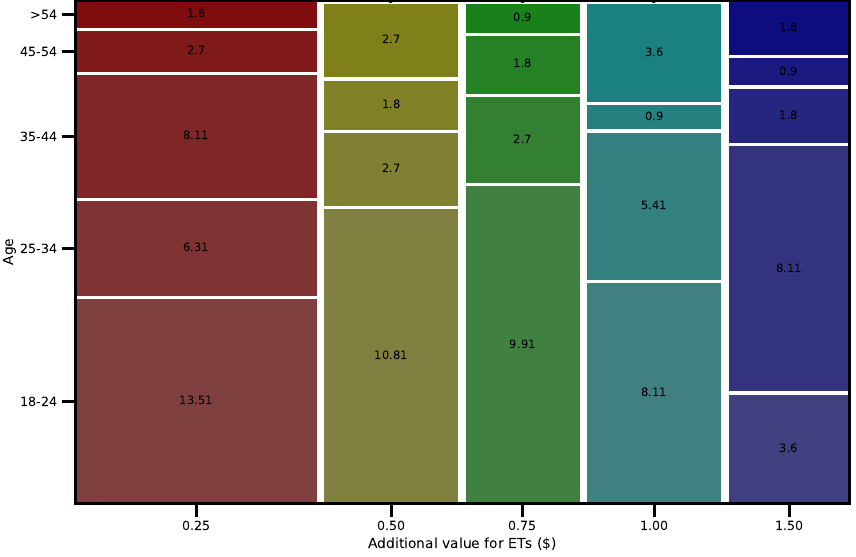
Figure 6. Mosaic plot of the willingness to pay an additional value for ETs based on age.